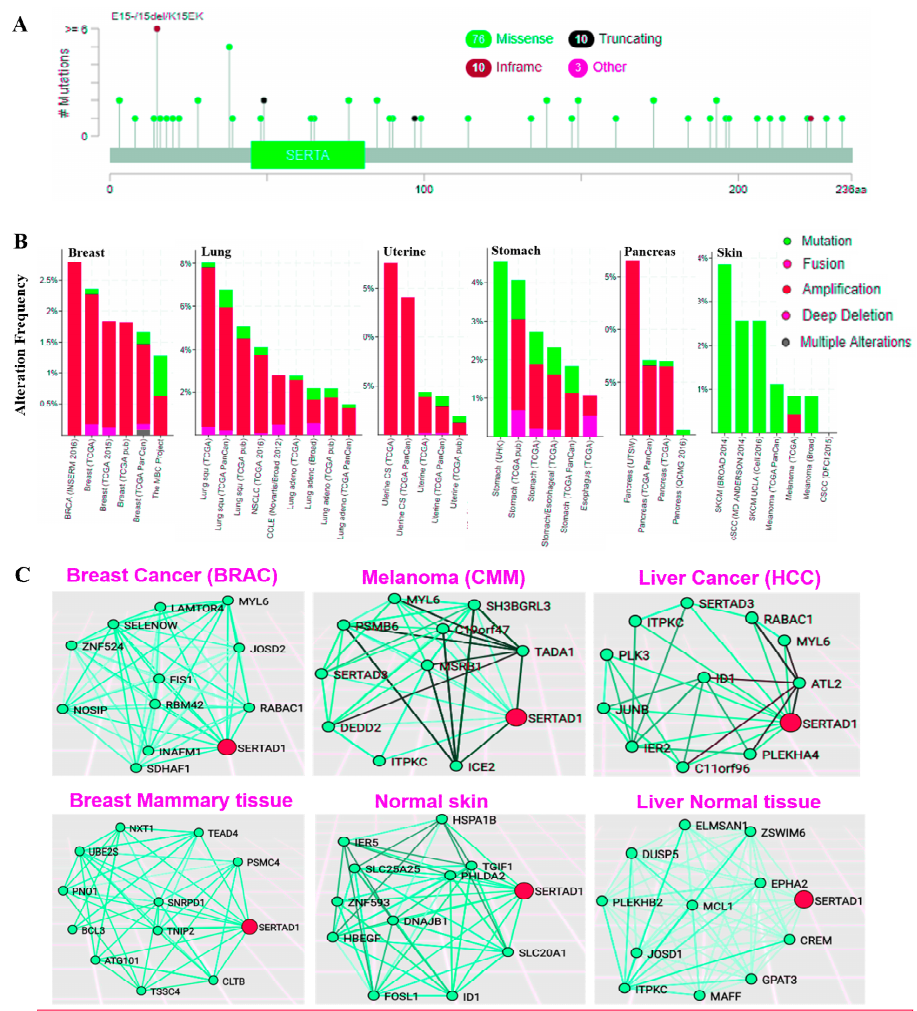
Figure 6. Aberrant transcribed and major mutation of SERTAD1 in different types of cancers across protein domains. ( A ) A total of 99 mutation sites were detected and located between amino acids 0 to 236 of SERTAD1. SERTAD-1 mutation mainly occurred in Pancreatic and uterine cancer. Moreover, hotspot area of mutation was found near SERTA and cycling binding domain, ( B ) The alteration frequency of a SERTAD1 gene was determined using cBIOPortal. Depicted cancer types containing >100 samples and alteration frequency of >15% are shown. The potential alteration frequency included deletions (Blue), amplification (Red), multiple alteration (Grey), or mutation (Green). The correlation between the alterations of SERTAD1, a putative target of cancer, across different cancer types. Data was obtained from the cBioportal for cancer genomics (Memorial Sloan-Kettering Cancer Center, New York, NY, USA). ( C ) Tissue and Cancer Specific Biological Network. SERTAD1 play a positive or negative regulator. Comparative network analysis showed crucial role of SERTAD1 breast cancer as positive regulator of all correlated genes in Normal and BRAC tumor ( C . Left upper and bottom), Potential role of SERTAD1 in melanoma where it is inhibiting function of TADA1 and ICE2 ( C . Middle upper and bottom). Co-expression networking of SERTAD1 showed as negative regulator for ALT2 in liver cancer HCC ( C . Right upper and bottom). Gene MYL6 positively correlated by SERTAD1 in breast, melanoma and HCC. TCSBN network derived based on manual filtered maximum number of nodes and Edge Pruning Parameter (−log10 P) and (min-0 max-50): 2 respectively. The database to explore the neighbors of a query gene SERTAD1 (red color) have been analyzed.